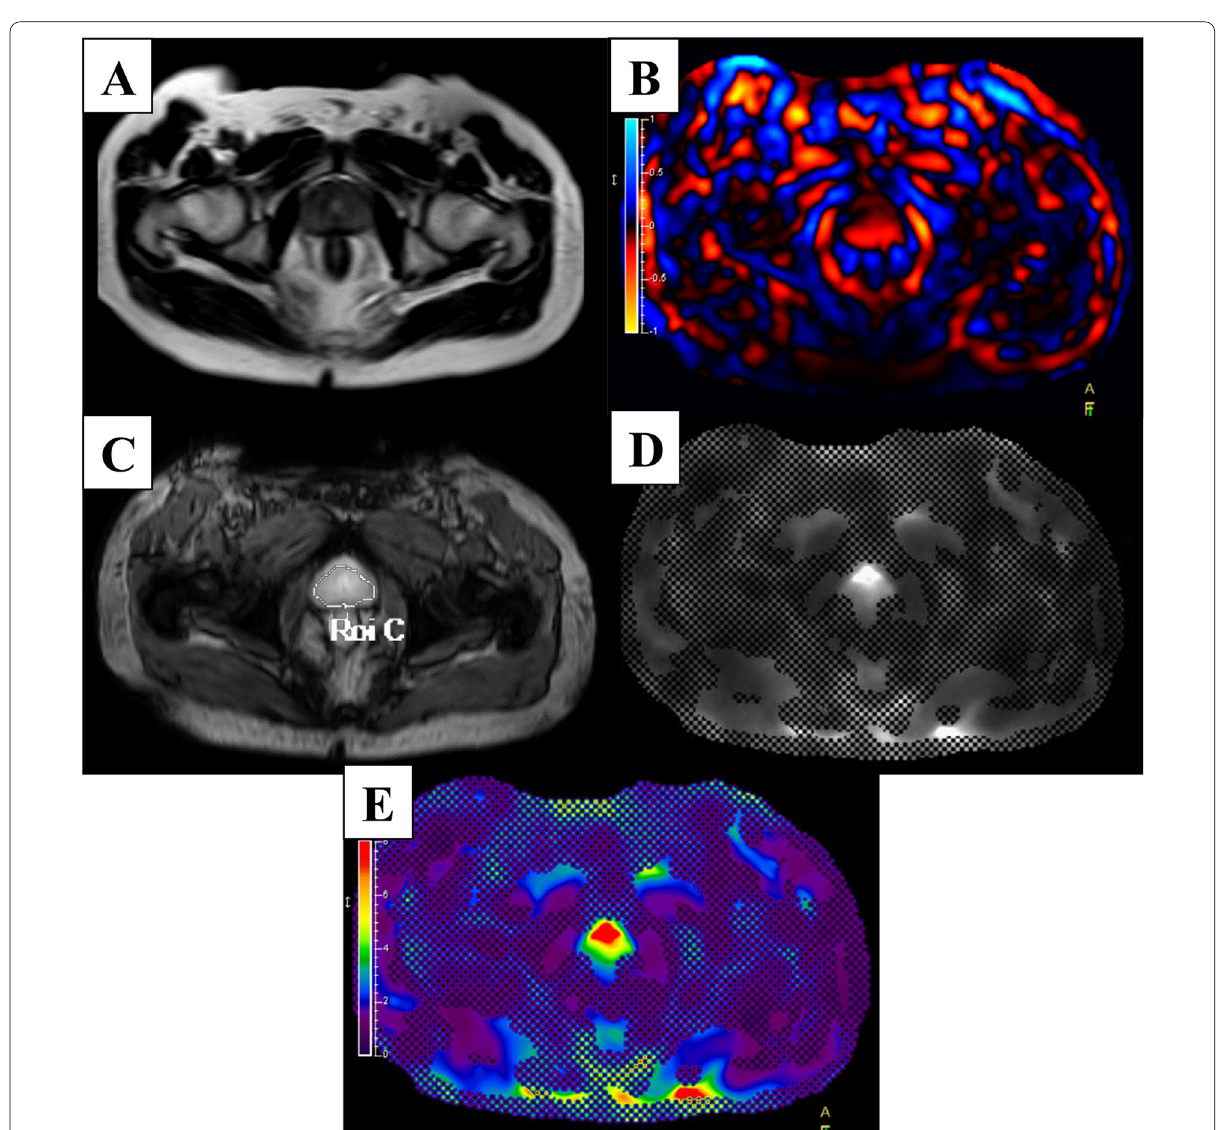
Fig. 1 Demonstrating MRE images in one same slice. A T2W image. B Wave image. C FFE image. D Modulus image. E Stiffness